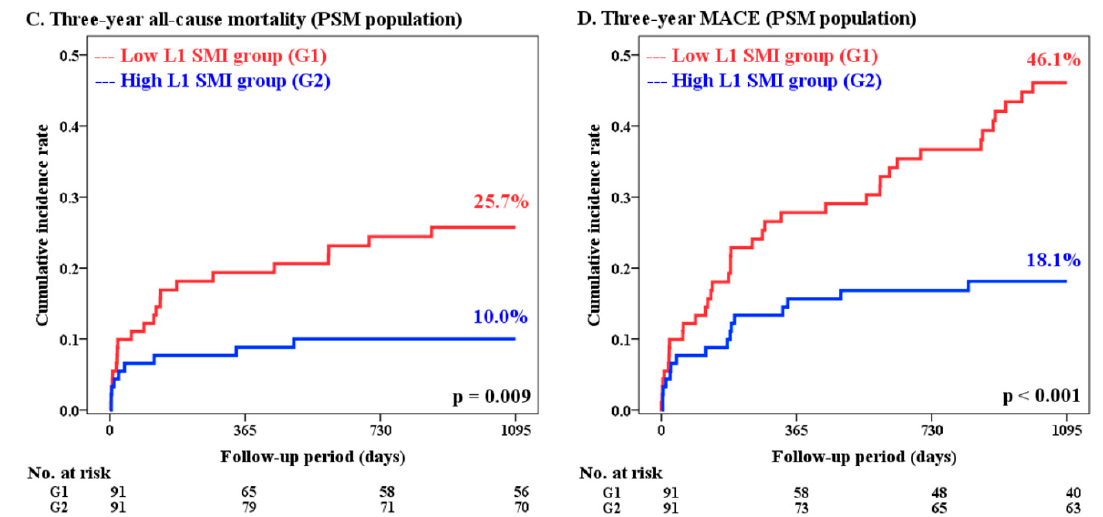
Figure 2. Cumulative incidence rates of 3-year clinical outcomes according to the groups divided by L1 SMI. Results for the overall population ( A , B ) and PSM population ( C , D ) are displayed: 3-year all-cause mortality ( A , C ) and 3-year MACEs ( B , D ). L1 = first lumbar vertebra; MACE = major adverse